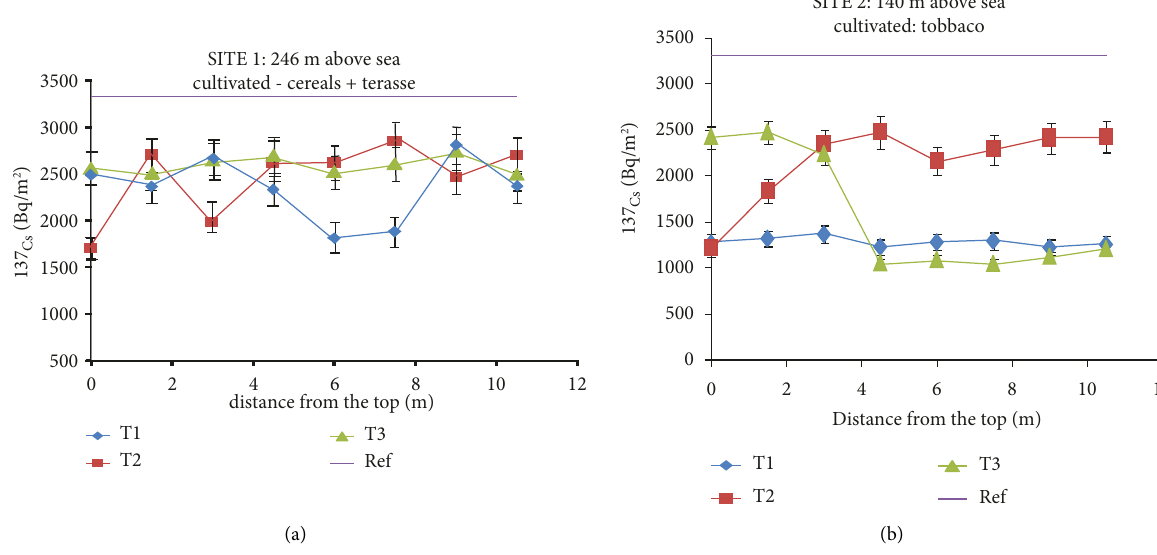
Figure 2: 137 Cs inventories (Bq/m 2 ) along 3 transects associated with site 1 (a) and site 2